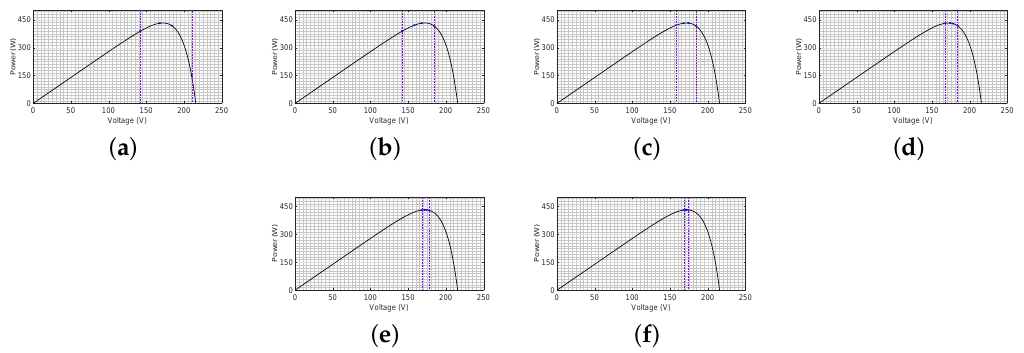
Figure 16. GSS bracketing MPP. ( a ) 1st; ( b ) 2nd; ( c ) 3rd; ( d ) 4th; ( e ) 5th; and ( f ) 6th iteration.